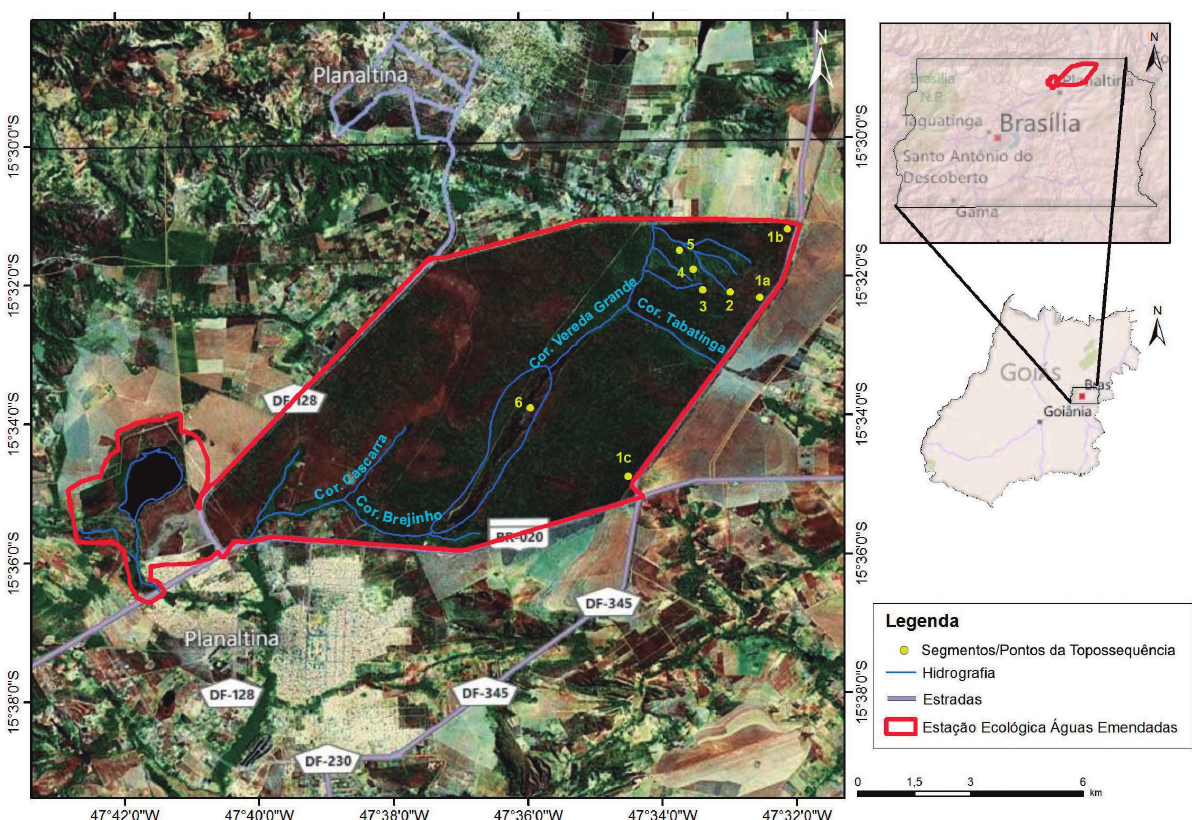
figura 1. localização da área e dos segmentos da topossequência de estudo. fonte: imagem de satélite tm landsat 5, de agosto de